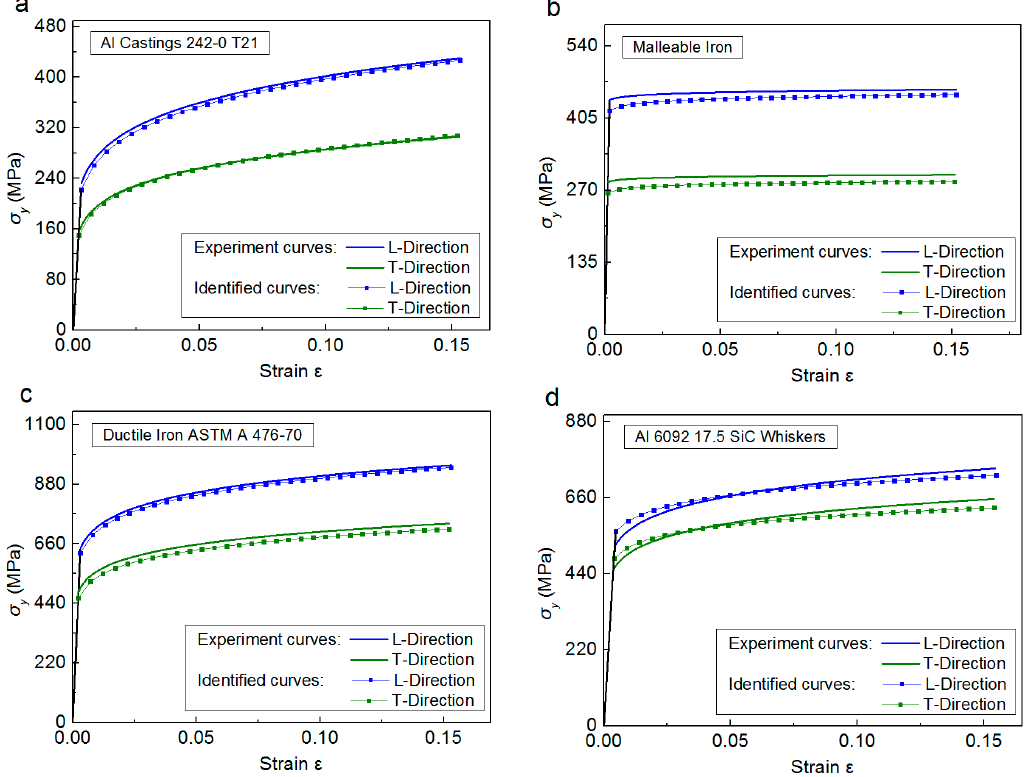
Figure 13. Comparison of the stress strain curves of four anisotropic materials between the FE “Input” values and these obtained from indentation and inverse analysis: ( a ) Al Castings 242.0-T21; ( b ) Malleable Iron; ( c ) Ductile Iron ASTM 476-70; ( d ) Al 6092 17.5 SiC Whiskers. It is noted that, the inverse identified (cid:2026) (cid:3026)(cid:3021) and (cid:2026) (cid:3026)(cid:3013) are very accurate, because their maximum error value is less than 10%. While, the identified n shows relatively larger error values, which indicates n is more sensitive to some numerical uncertainties, e.g., numerical oscillation and fitting imprecision. In Table 6, the maximum error of n is about 20%, e.g., Al 6092 17.5 SiC Whiskers. Here, the FE “input” n of Al 6092 17.5 SiC Whiskers is 0.1, while the inverse identified n is 0.08. The difference of these two n values is 0.01, and it is twice bigger than the value of Δ(cid:1866) , 0.01 used in the